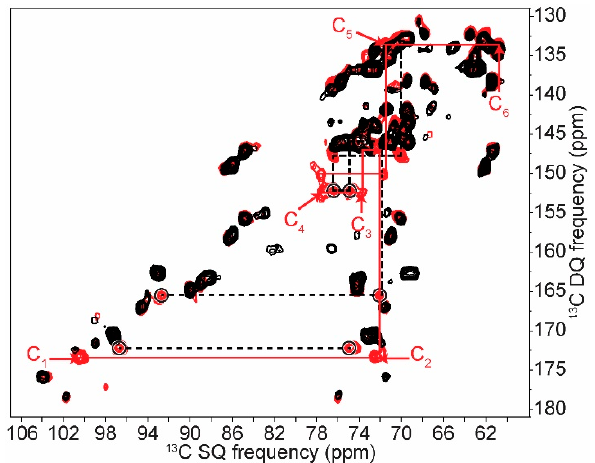
Figure 6. NOE-INADEQUATE of whole cell C. reinhardtii wt (red) and sta 6-1 starchless (black) strains. Continuous lines indicate correlation pathways corresponding to A-type crystalline starch. Dashed lines link circled resonances from the additional correlations discussed in the